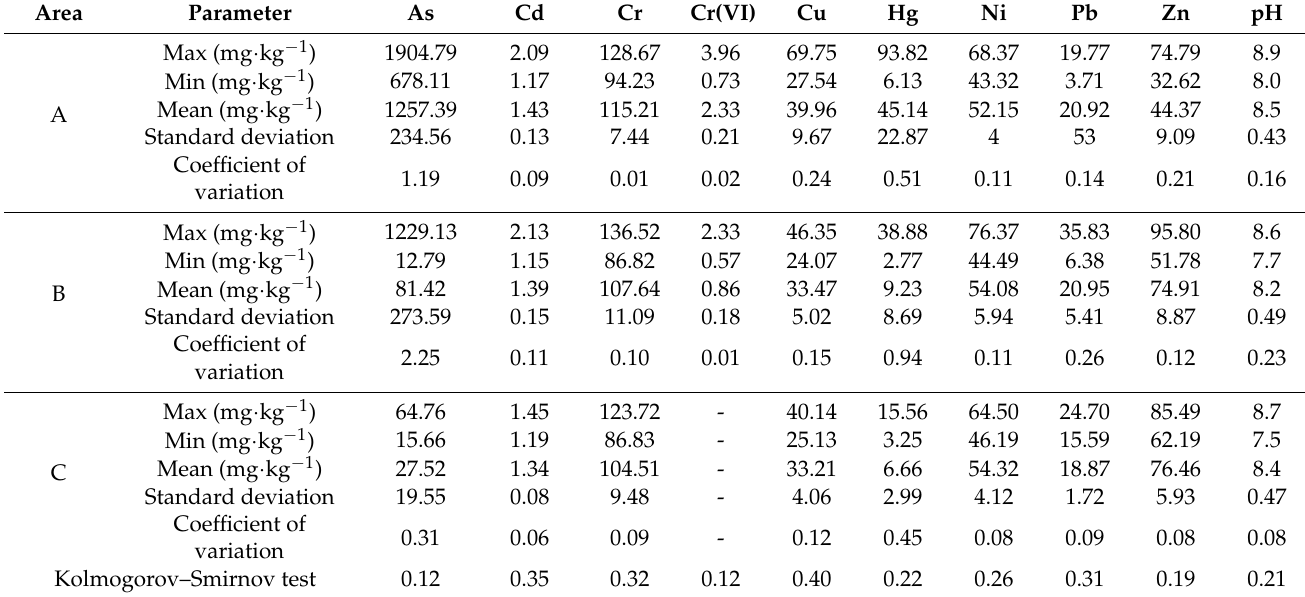
Table 7. Soil-heavy metal concentrations in the mining area.